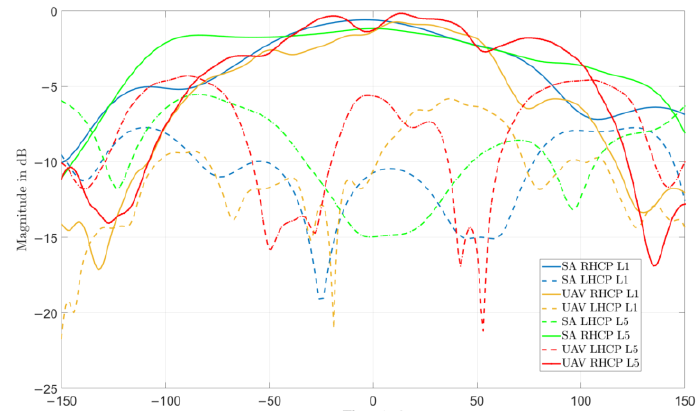
Figure 16. Phi = 0 ◦ cut of the measured RHCP and LHCP realized gain patterns of the miniaturized GNSS array (without vertical choke rings) standalone (“SA”) or installed on a hex-rotor UAV (“UAV”) with an installation height of 110